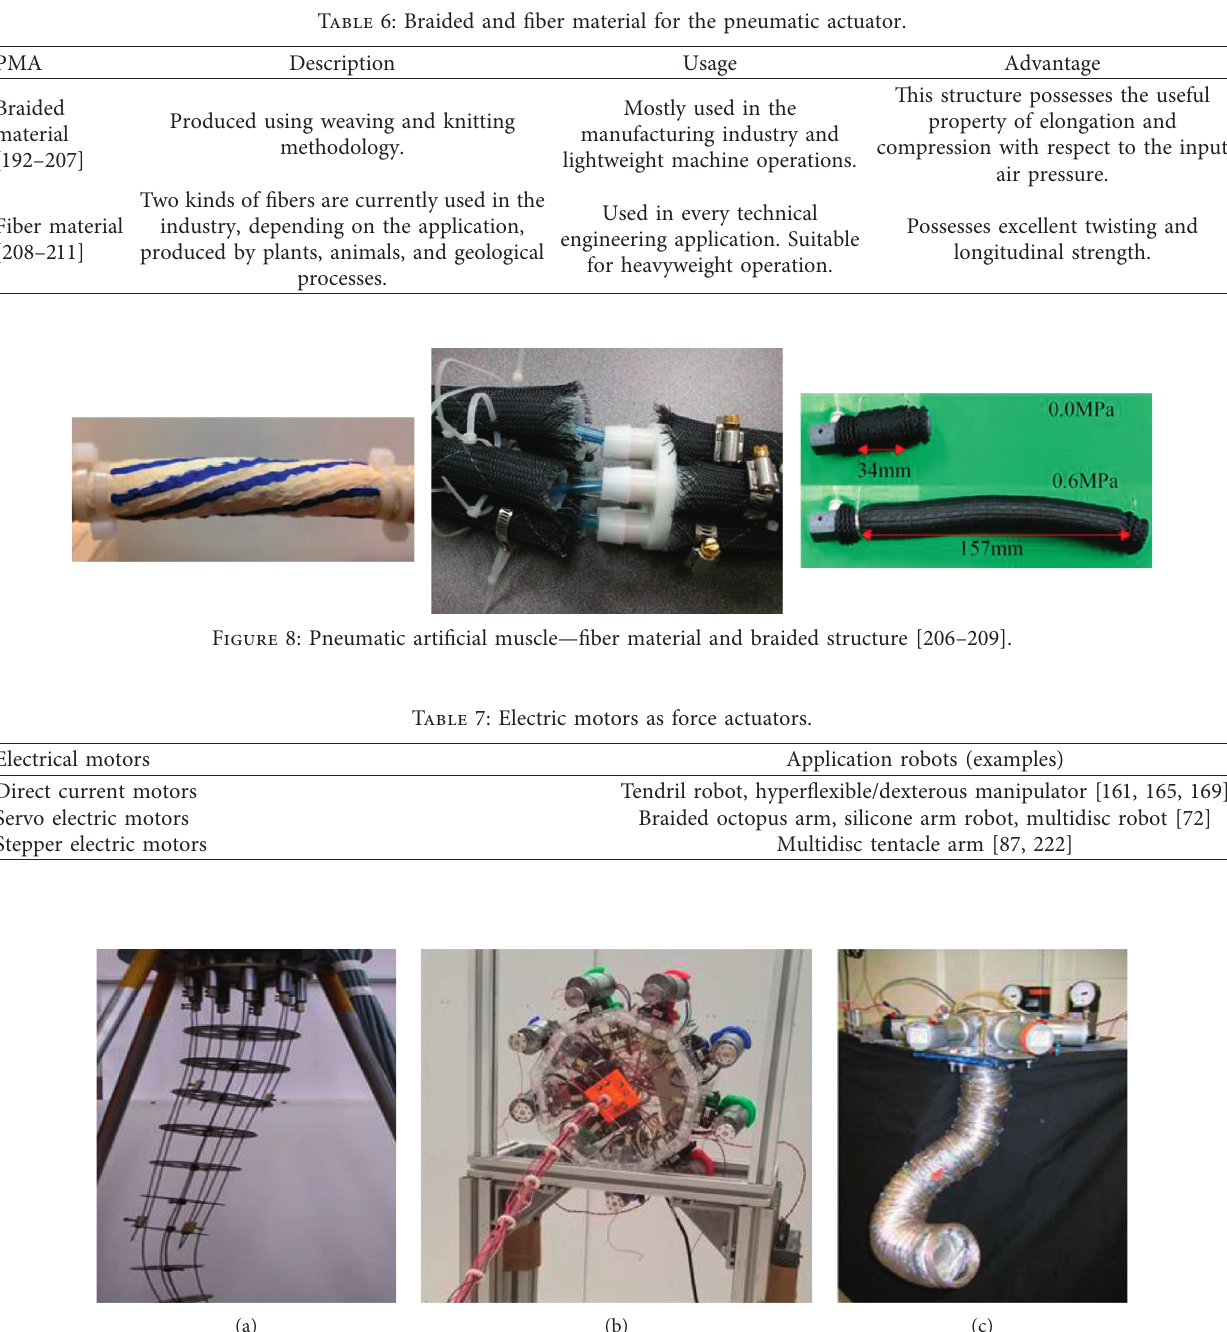
Figure 9: Drive mechanism: (a) tendon alignment [87], (b) electric motor [162]—tendon, and (c) pneumatic [16]—nontendon.